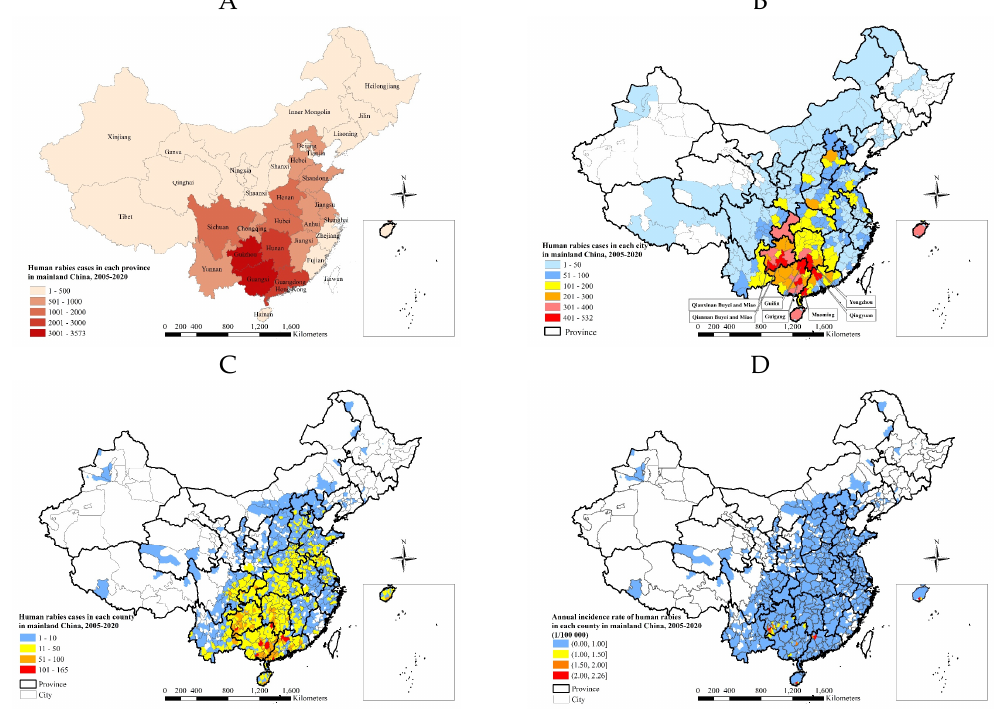
Figure 2. Spatial distribution of human rabies in mainland China, 2005–2020. A. Cases in each prov- ince. B. Cases in each city. C. Cases in each county. D. Incidence rate in each county. province. ( B ). Cases in each city. ( C ). Cases in each county. ( D ). Incidence rate in each county. The city with the highest number of cases, 532, was located in Qianxinan Buyei and Miao Autonomous Prefecture, Guizhou Province. Six cities with 400–500 reported human rabies cases were located in Guizhou, Hunan, Guangdong, and Guangxi Provinces (Fig- ure 2B). (Figure